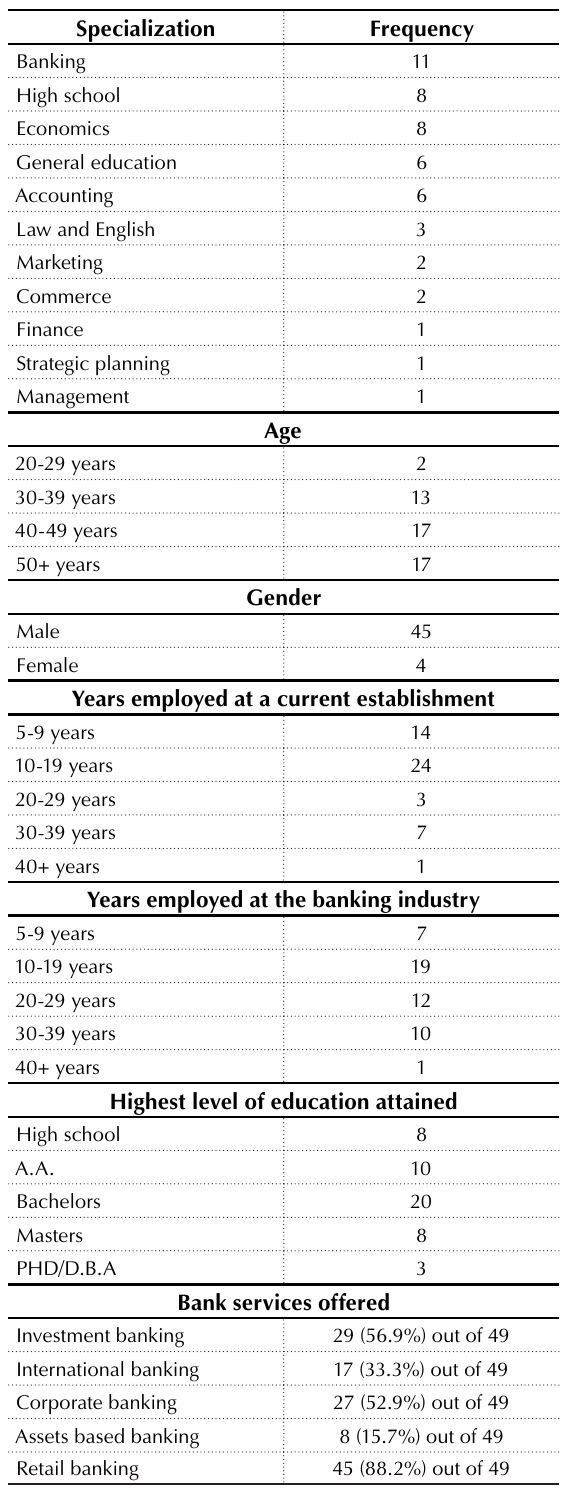
Table 1. The major demographic characteristics of the 49 potential respondents